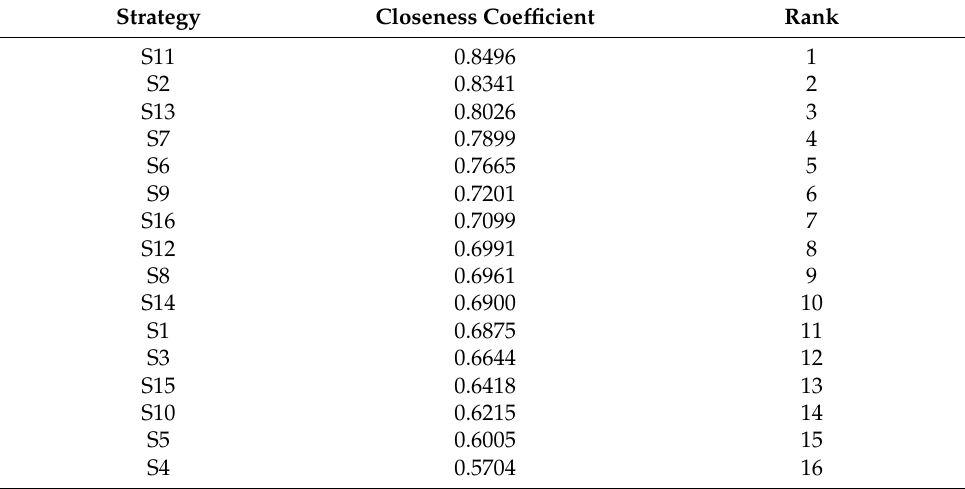
Table 3. CLP improvement strategy